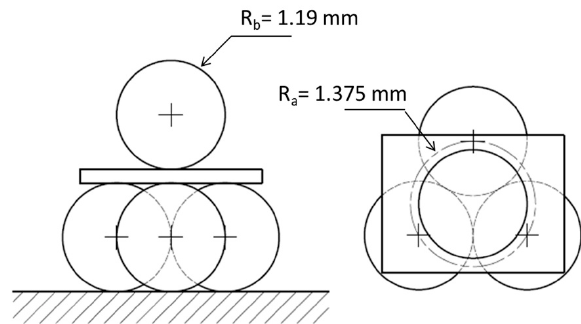
Materials 2018 , 11 , x FOR PEER REVIEW Figure 2. Scheme of the ball-on-3-balls test setup for biaxial testing. Figure 2. Scheme of the ball-on-3-balls test setup for biaxial testing.